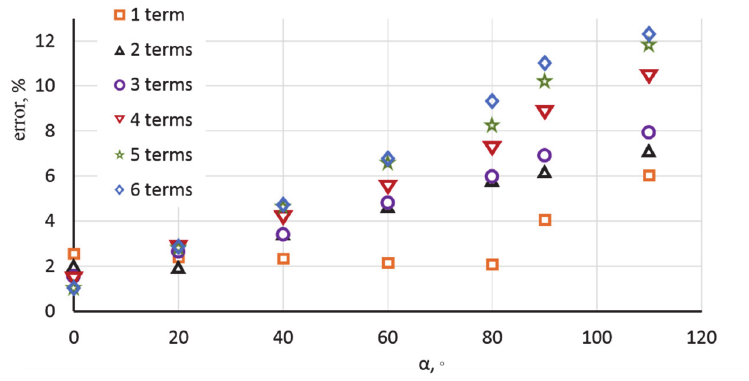
Figure 4: Effect of α angle on the error for estimating the